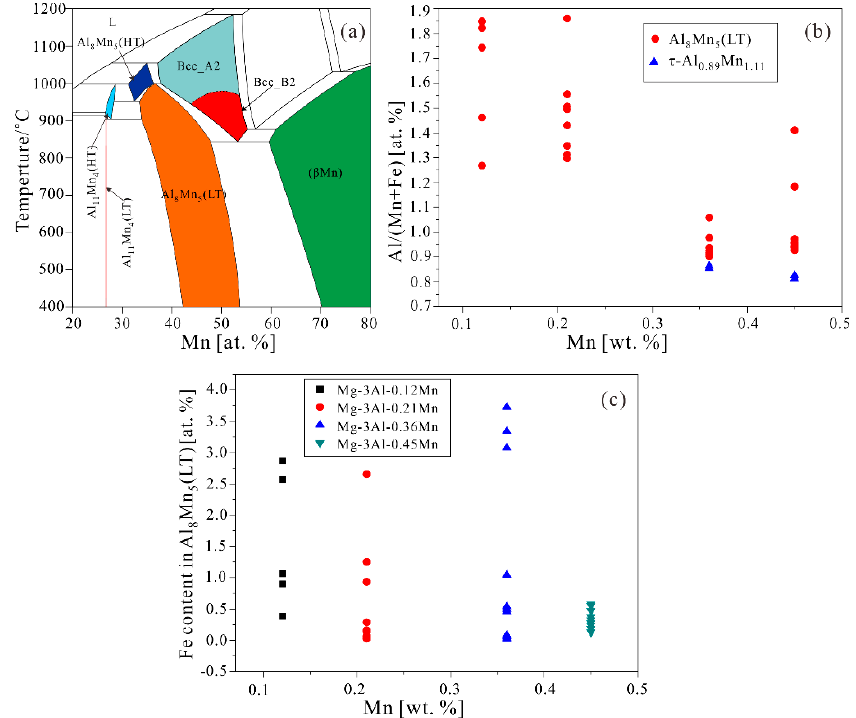
Figure 9. ( a ) Calculated partial Al-Mn phase diagram based on the self-constructed database, ( b ) the Al/(Mn + Fe) ratio of the particles in the Mg-3Al- x Mn alloys by EPMA, ( c ) determined Fe content in Al 8 Mn 5 (LT) (Al 8 Mn 5 in low temperature) of the Mg-3Al- x Mn alloys by EPMA.